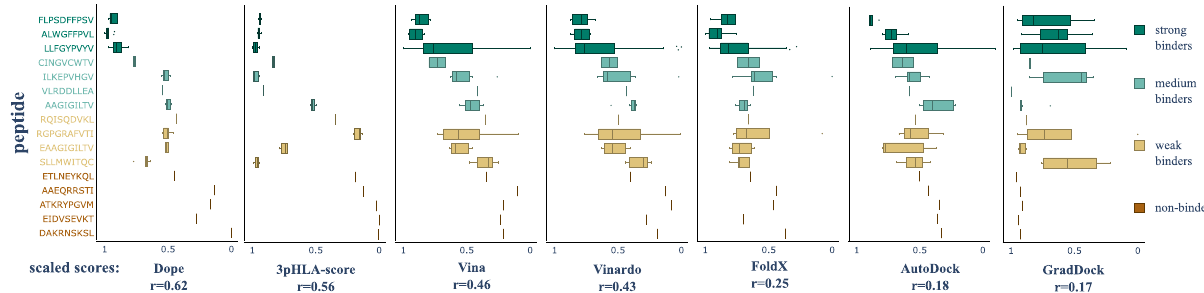
Figure 4. Performance of different scoring functions in evaluating the binding affinity of structures from the independent Dataset 3. Pearson’s correlation coefficient is indicated next to the name of the scoring function. Peptides involved in the structures of Dataset 3 (see Table S4) are listed on the y-axis. The peptide names and corresponding box plots are colored and arranged along the y-axis according to their experimental binding affinity (ranging from dark green, strong binders, at the top, to dark orange, non-binders, at the bottom). Predicted scores scaled to the range 1-0 are plotted on the x-axis (1-highest predicted binder; 0-non-binder). The correlation is calculated for the predicted binding affinity of each of the 82 structures present in Dataset 3 with respect to their experimental binding affinities.